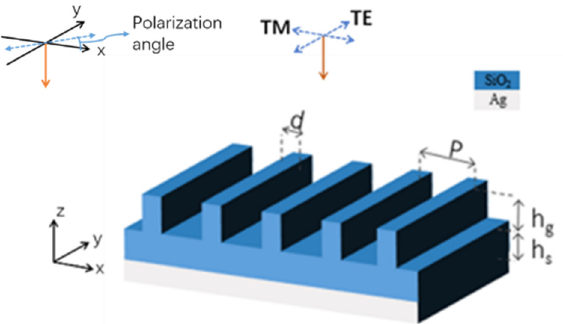
Figure 3. Basic structure of proposed silica grating. The period ( P ) of the grating is 12 µ m. The ridge width ( d ) of the grating is 2 µ m. The thickness of the silica layer ( h s ) is 100 µ m. The height ( h g ) of the grating is 18 µ m. The height ( h g ) can be reduced to 6 µ m by sacrificing the absorption efficiency. The blue dotted line with double arrows represents the direction of the incident electric field.